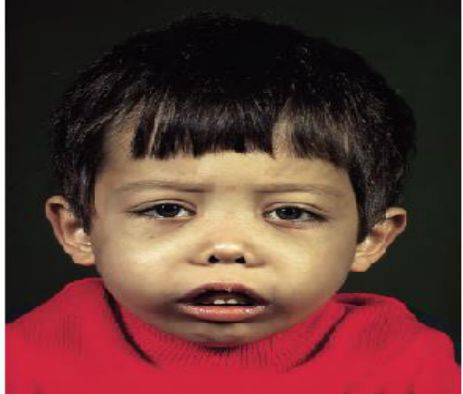
Figure 2. The facial appearance of a child with β‐ TM (1)